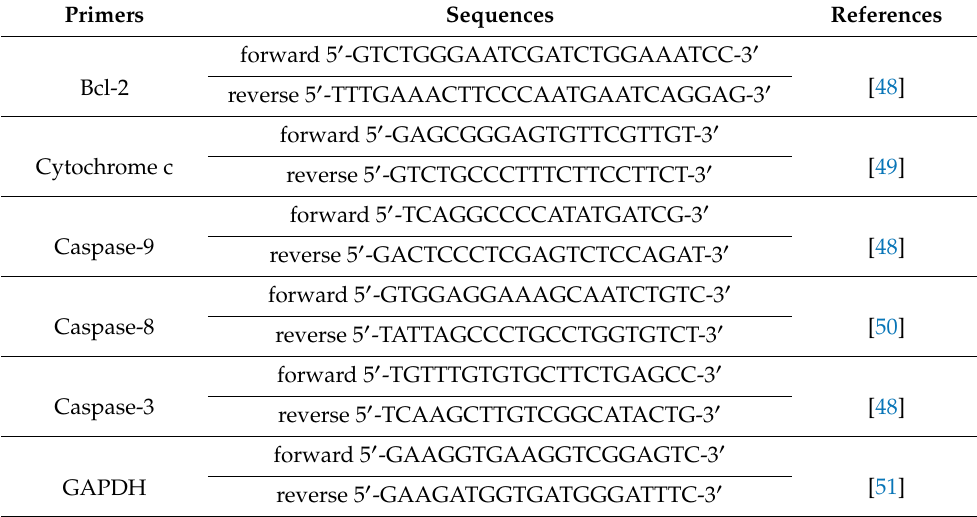
Table 2. Sequence of primers used in real-time PCR